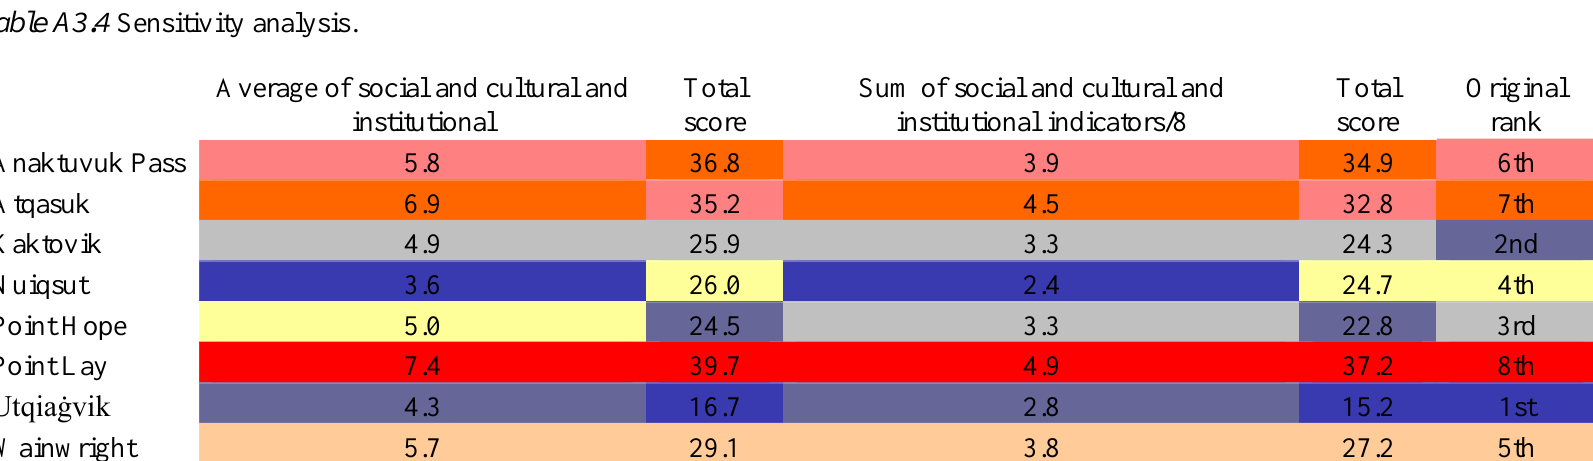
Table A3.4 Sensitivity